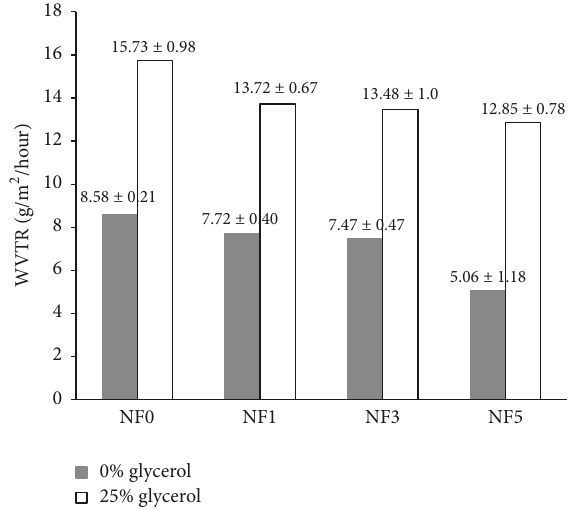
Figure 2: Water vapor transmission rate of TPS-PVA cellulose nanocomposite films.